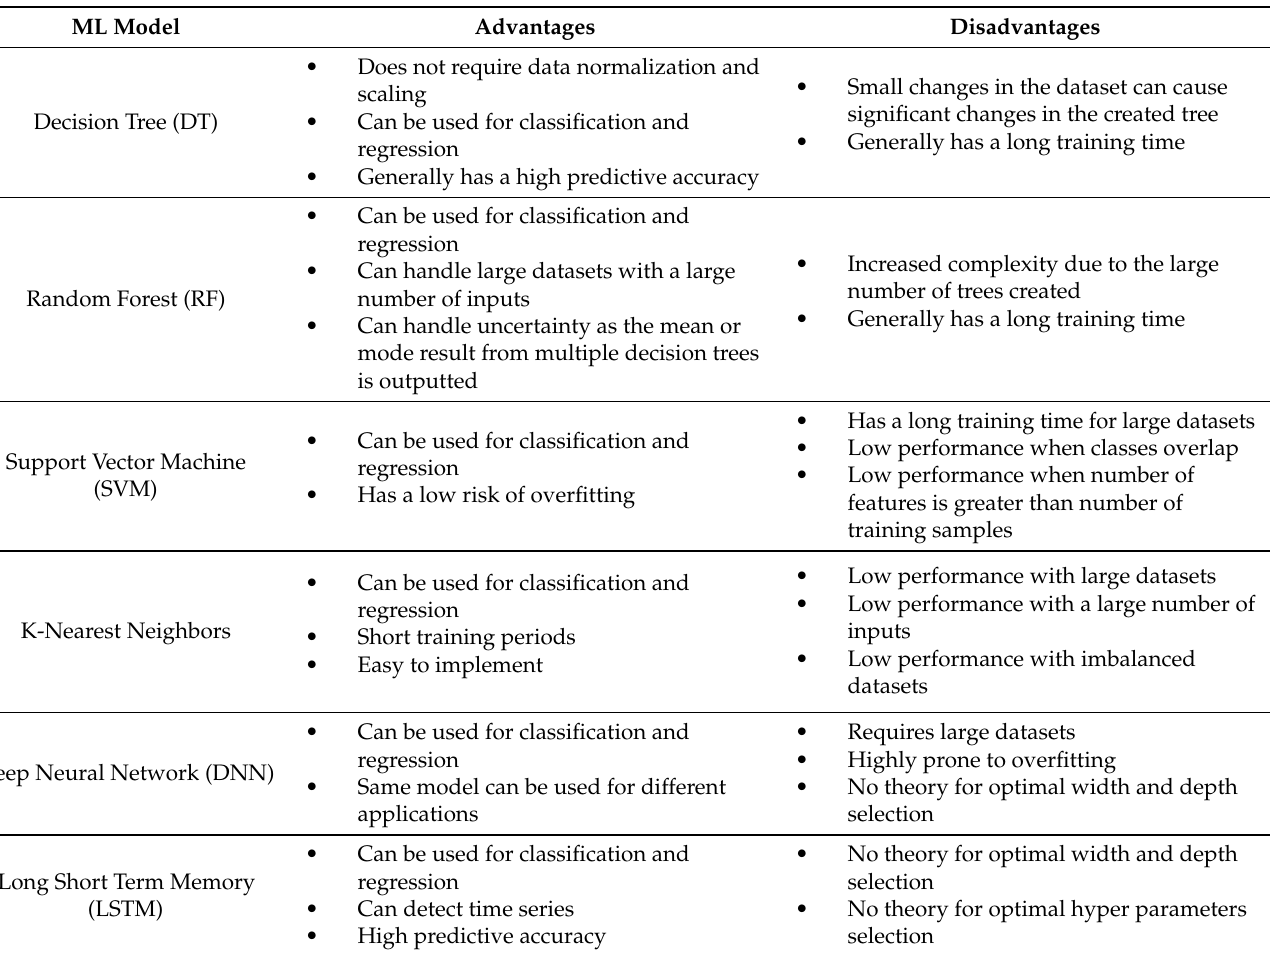
Table 1. Summary of ML